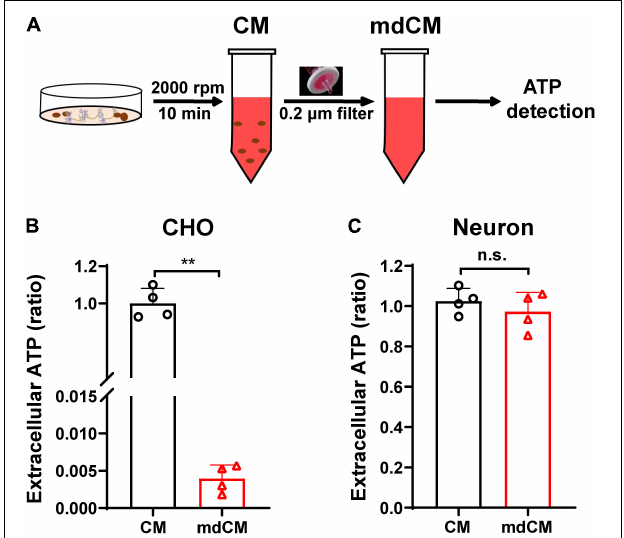
FIGURE 1 | Extracellular ATP detected in the CM and mdCM of CHO cells and neurons. (A) The CM was collected by spin cell debris down with centrifuging at 2,000 rpm for 10 min, and the mdCM was collected by passing the CM through the 0.2 µ m sterile filter. (B) Significant decrease of extracellular ATP concentration in CHO cells was observed after removing mitochondria from the CM of CHO cells. (C) No changes in extracellular ATP concentration were observed after removing mitochondria from the CM of neurons. n = 4. ** p < 0.01 vs. CM. CM, culture medium; mdCM, mitochondria-depleted CM; n.s., not